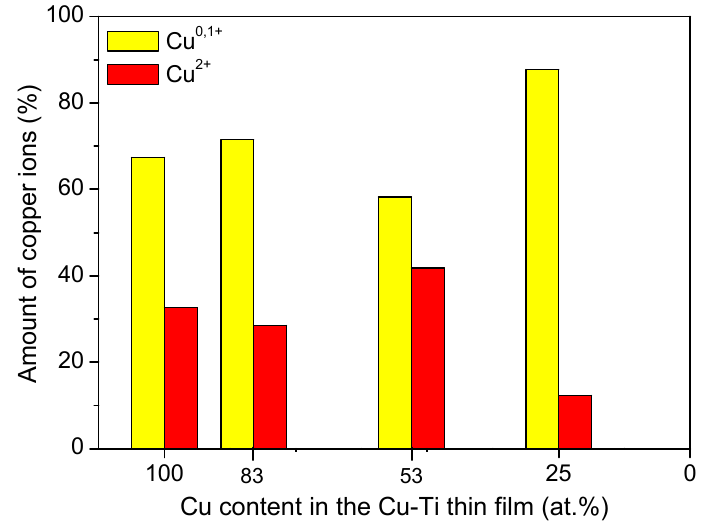
Figure 11. Influence of the Cu content in the nanocrystalline Cu-Ti thin film on the percentage amount of Cu 0,1+ and Cu 2+ ions on its surface.